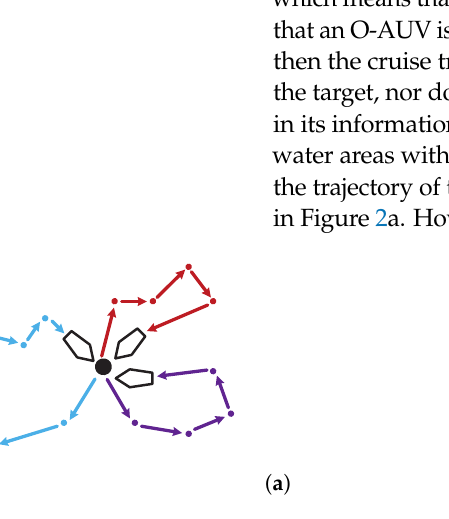
Figure 2. Multiple trajectory planning problem. ( a ) Multiple trajectory planning problem for AUVs. ( b ) Multiple trajectory planning problem for